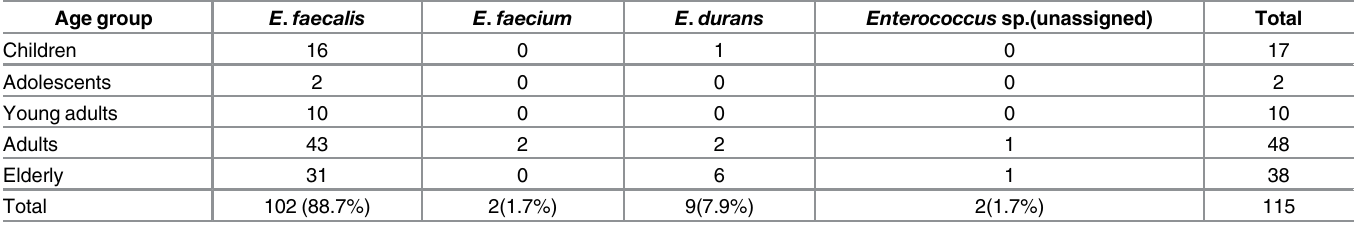
Table 2. Distribution of Enterococcus species in each age group. Age